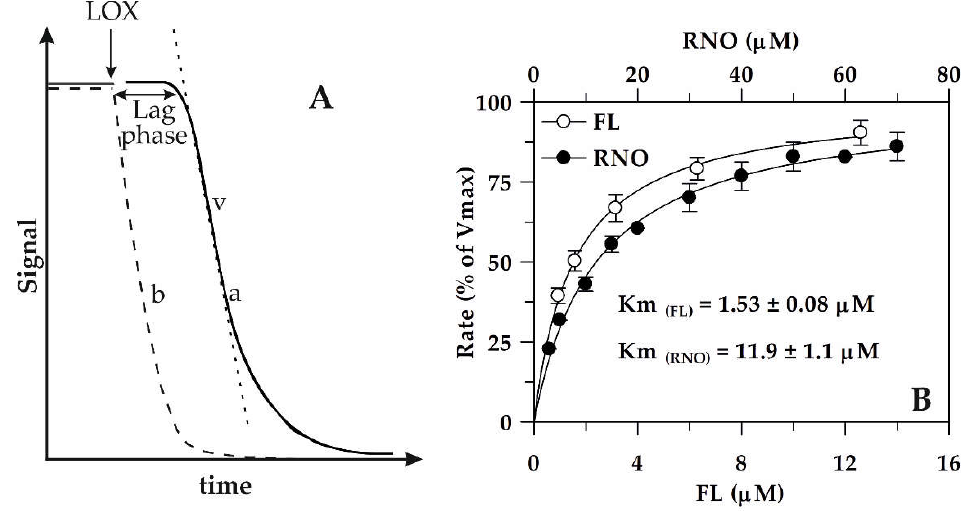
Figure 1. Kinetics of RNO bleaching and FL quenching catalyzed by soybean LOX-1. ( A ) Typical experimental traces are reported relative to: (i) spectrophotometric (or fluorimetric) measurement of the LOX-1-dependent RNO bleaching (or FL quenching) reaction (trace a) and (ii) simultaneous polarographic measurement of LOX-1-catalyzed oxygen uptake (dotted line, trace b). The reaction rate (v) and the lag phase are also indicated. ( B ) The rates of RNO bleaching and FL quenching, expressed as (%) of Vmax, are reported as Michaelis-Menten plots. The values of 100% Vmax correspond to 0.27 ± 0.10 ∆ A 440 · min − 1 and 0.28 ± 0.01 ∆ A 485 · min − 1 for LOX/RNO and LOX–FL reactions, respectively. Km values are also reported. Data are recalculated from those reported in Pastore et al. [25] and Soccio et al. [26] and expressed as mean value ± standard deviation ( n =